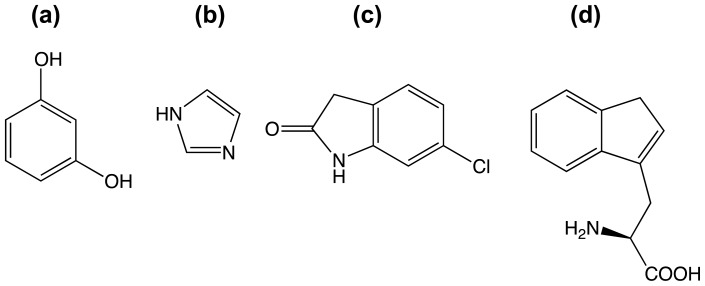
(a) Resorcinol; (b) Imidazole; (c) 6-Chlorooxindole; (d) (S)-2-amino-3-(1Hinden- 3-yl)propanoic acid.